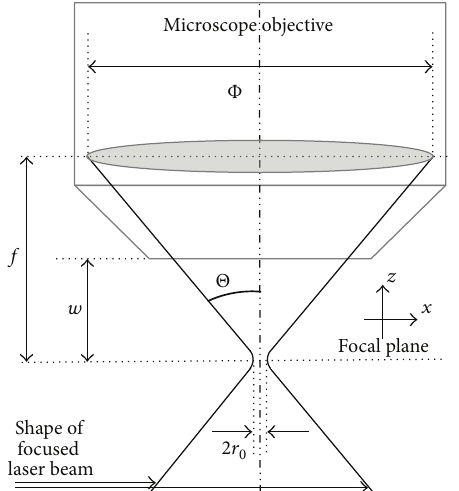
Figure 1: Schematic presentation of laser beam focused by micro- scope objective: 𝑓 : focal length, 𝑤 : working distance, 2 𝑟 0 : diameter of the focal spot, Θ : half-angle of maximum cone of light collected by microscope objective, Φ : entrance diameter of the objective, and 𝑥 , 𝑧 :